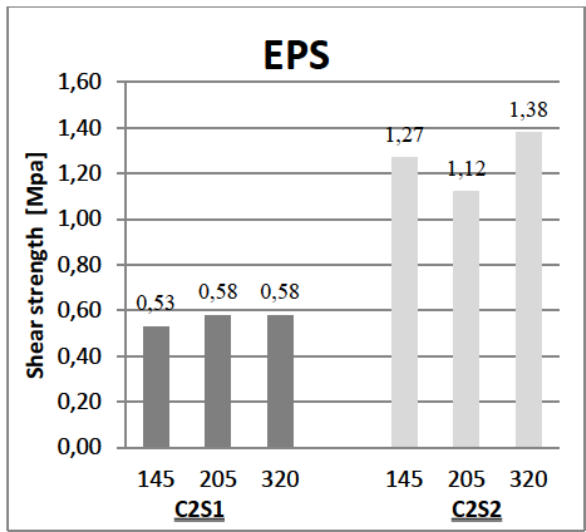
Figure 10: Average results of the shear strength tests; comparing the same EPS insulation to different mesh & adhesive